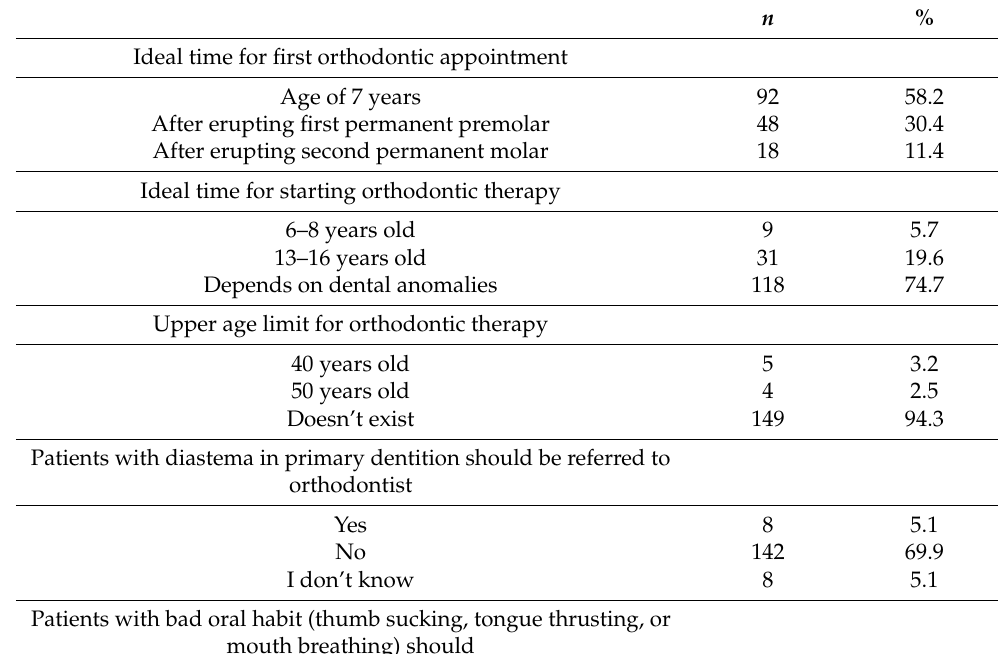
Table 2. Results from the questionnaire about attitude and awareness of principles and practices in